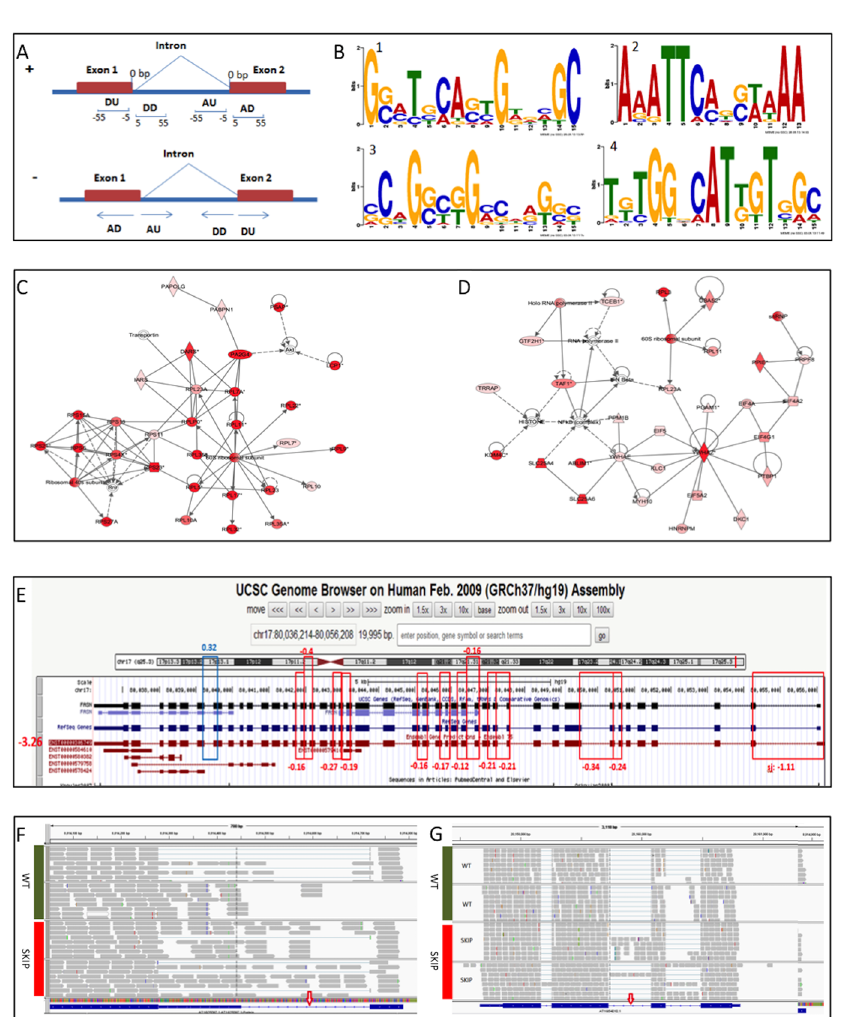
Fig 3. Motif analysis and multi-species comparison of splicing junctions and intron retentions. (A) Illustration of the donor upstream (DU), donor downstream (DD), acceptor upstream (AU), and acceptor downstream (AD) sequences used in the motif search. (B) Sequence motifs detected at flanking sequences of significant splicing junctions. Motif 1 – 4 corresponds to that in Table 3. (C) Networks from genes with significant splice junctions (SJs) in CG8144 RNAi, IPA score 59. (D) Networks from genes with significant SJs in CG10279 RNAi, IPA score 54. The color denotes the significance of the SJ within the gene: the darker the red is, the more significant the SJ in the gene is. (E) The consistent trend of the expression level of an isoform and the differential usage of its unique SJs between HER2+ and benign tumor samples. (F) and (G) Intron retentions detected in AT1G25097 and AT1G54010 genes from Arabidopsis RNA-seq analysis. Red arrows indicate the intron